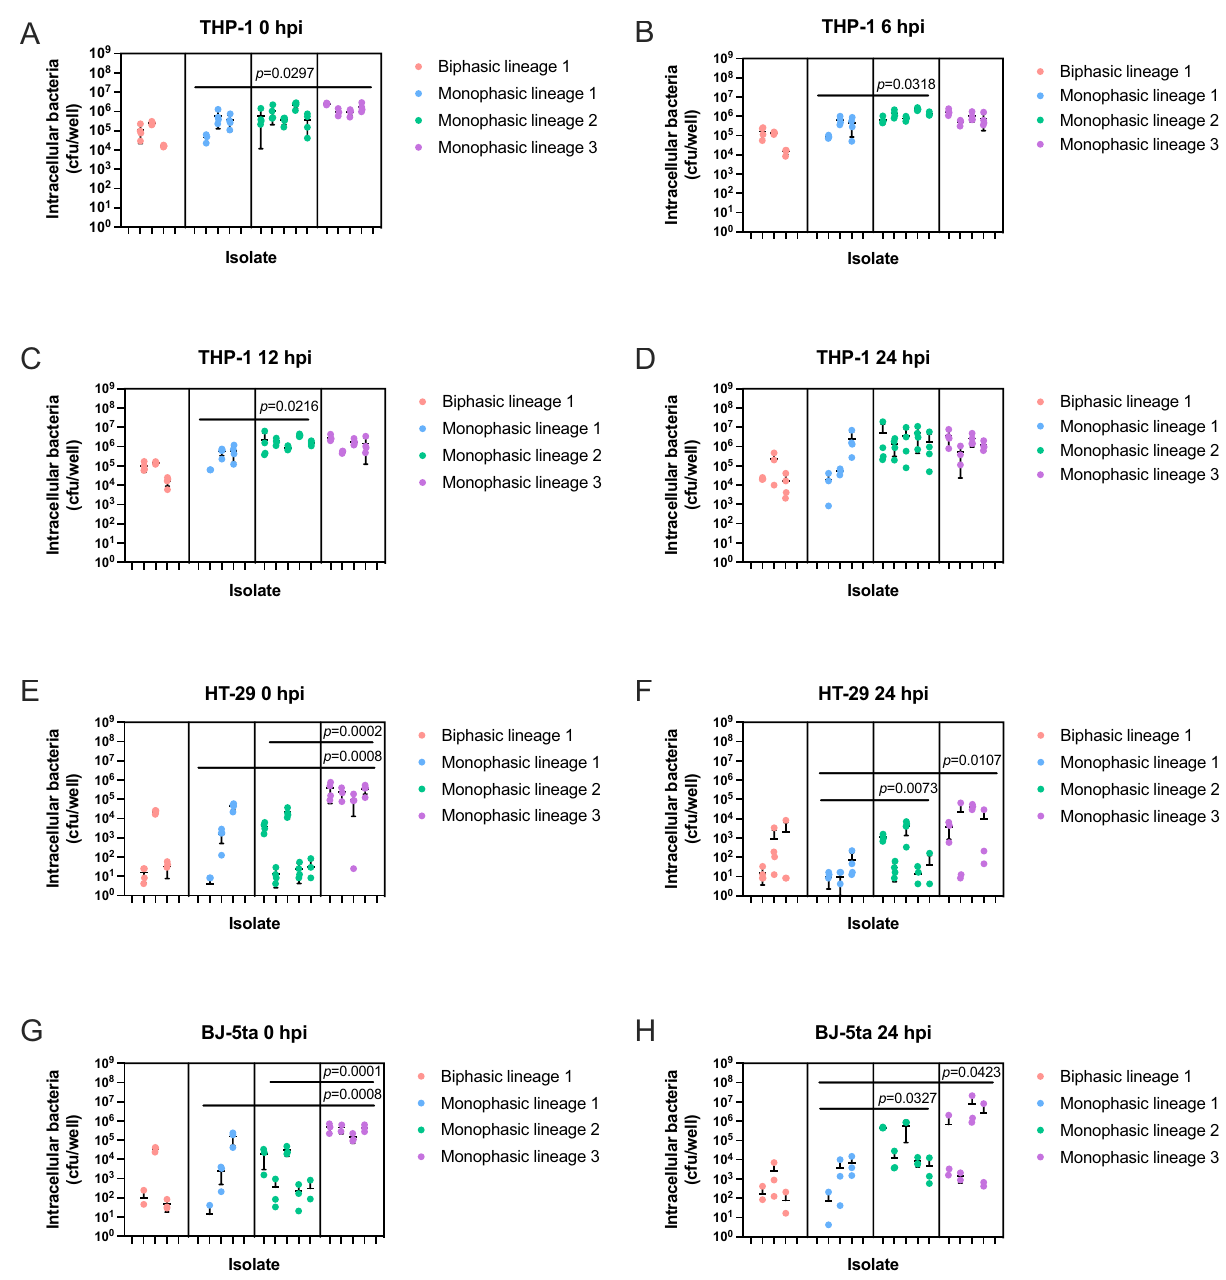
Fig. 4 Lineage 2 and 3 ST34 Salmonella 4,[5],12:i:- demonstrate increased infectivity and replication in human cell lines. Differentiated THP-1 (human monocyte) cells ( A – D ), HT-29 (human intestinal epithelial) cells ( E , F ), or BJ-5ta (human fi broblast) cells ( G , H ) were infected at an MOI:10 with selected ST34 Salmonella 4,[5],12:i:- and ST34 matched-Lineage 1 biphasic S . Typhimurium isolates (Supplementary Table 1). THP-1 cells were lysed and intracellular bacteria enumerated as CFU/well at times 0, 6, 12, and 24 hpi. HT-29 and BJ-5ta cells were lysed and intracellular bacteria enumerated as CFU/well at times 0 and 24 hpi. Isolates depicted on the x axis correspond to isolates listed in Supplementary Table 1. Each dot represents CFU/well of a biological replicate (performed in technical duplicate), with error bars indicating ±1 standard deviation of n = 3 or 4 biological replicates. Statistical signi fi cance was determined by nested one-way ANOVA with Fisher ’ s uncorrected multiple comparisons test. MOI multiplicity of infection, hpi hours post- infection, CFU colony-forming